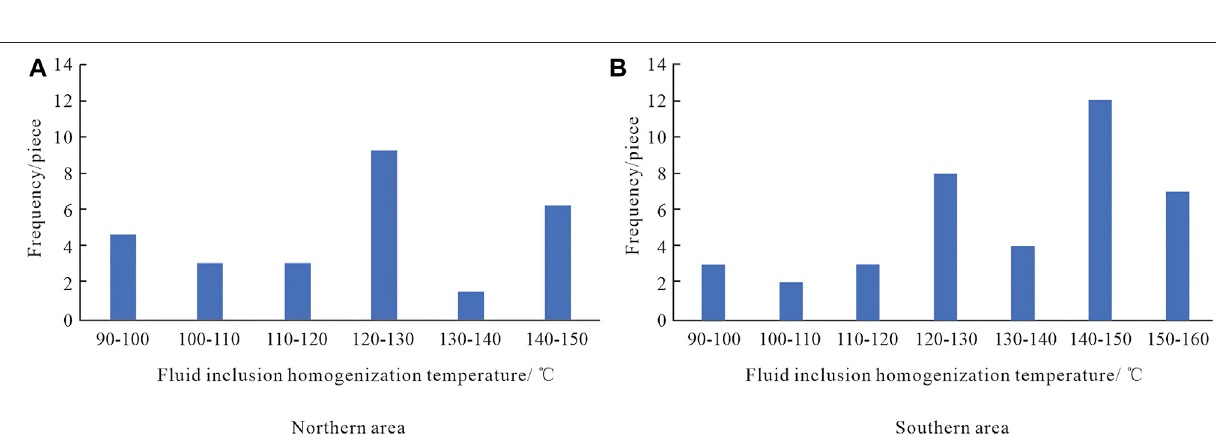
Frontiers in Earth Science |